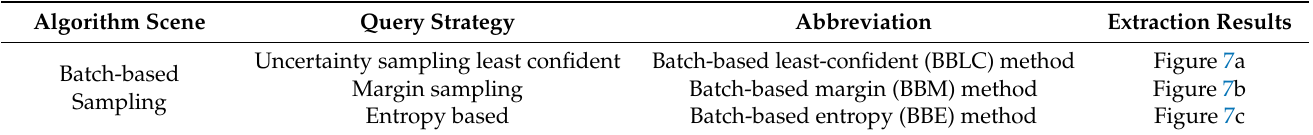
Table 6. Detailed processes of other query